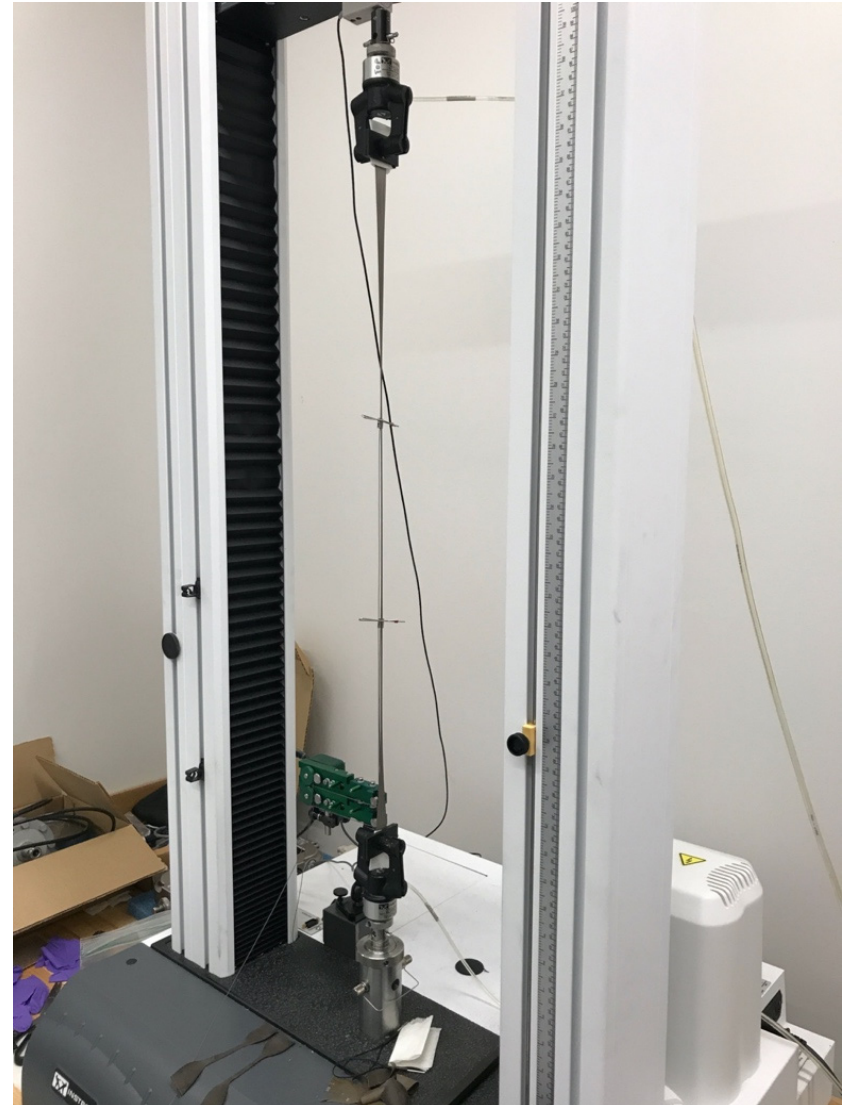
Figure 5. Mechanical testing of GNRL/micro-Bi 2 O 3 samples by Instron universal testing machine.